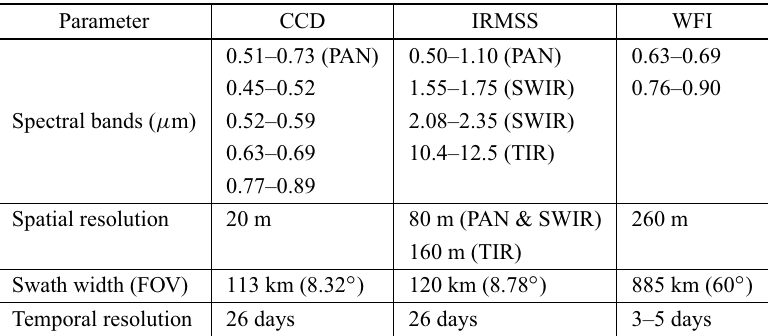
Spectral coverage of the CBERS-2